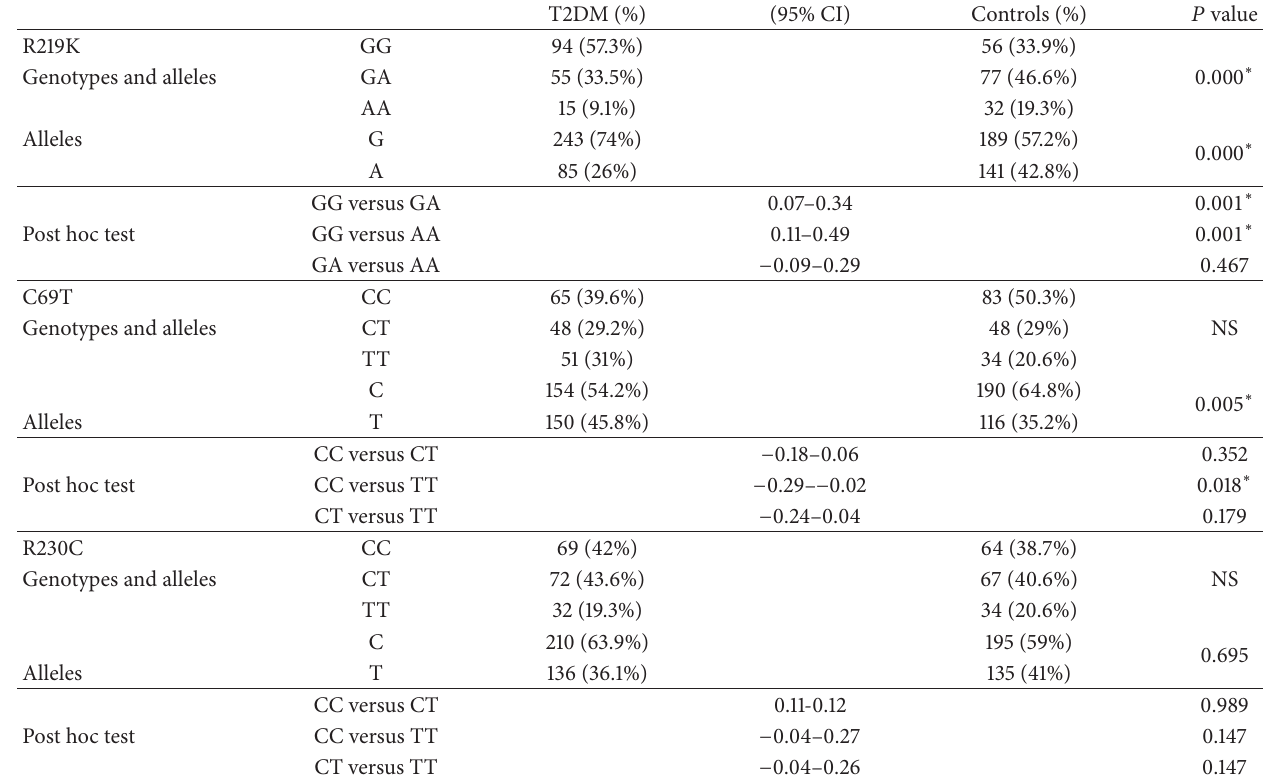
Table 2: Genotypic and allelic frequencies of R219K, C69T, and R230C, respectively, according to subjects.